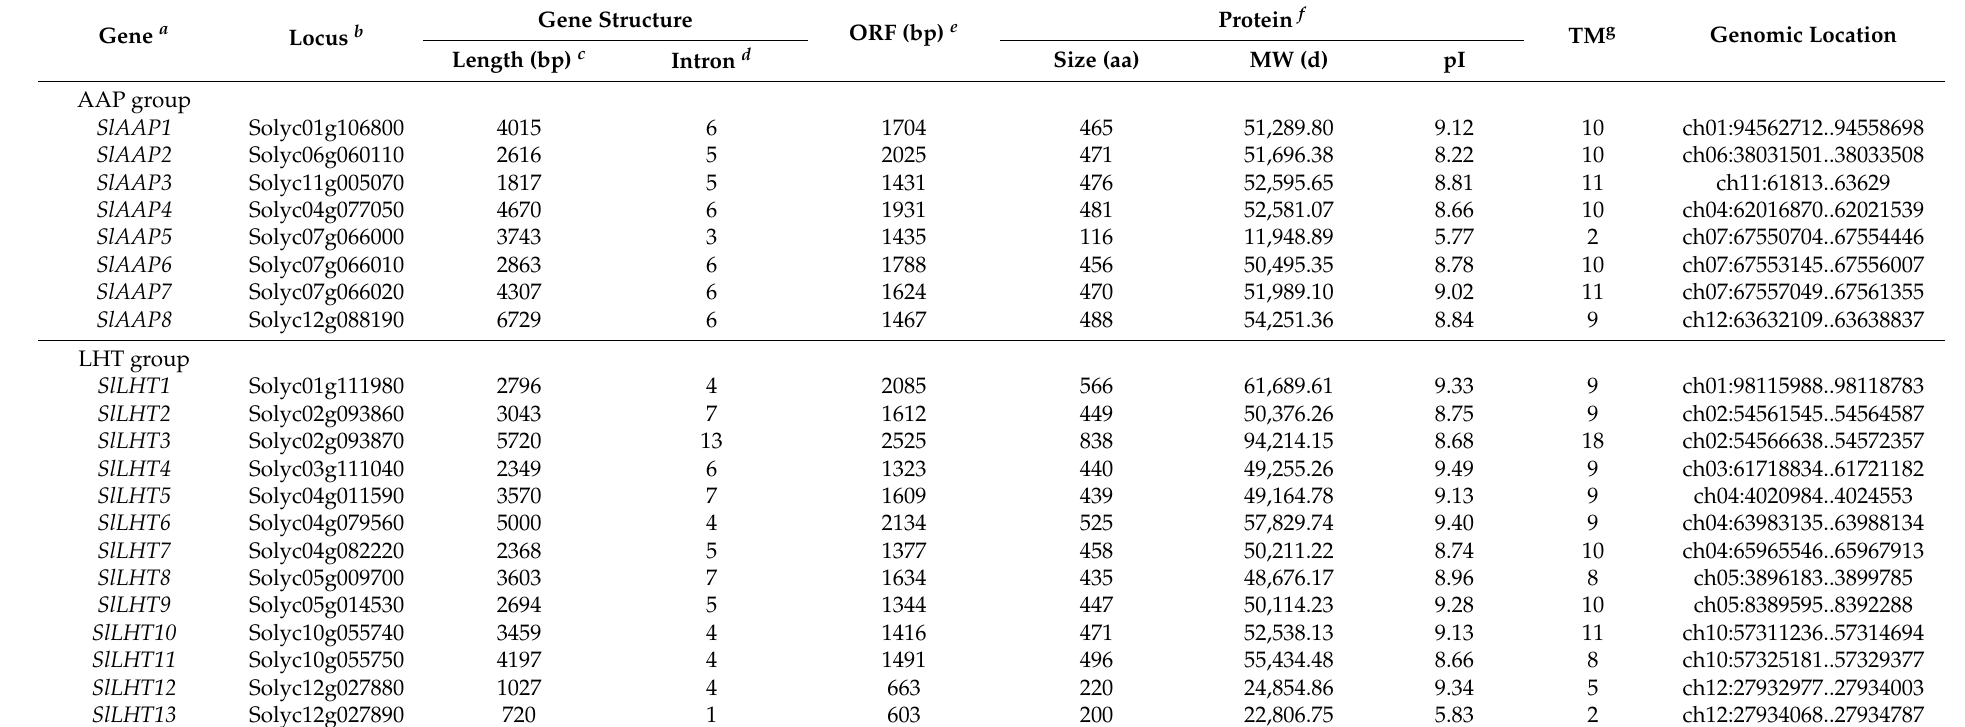
Table 1. The general information and sequence characterization of 88 SlAAT